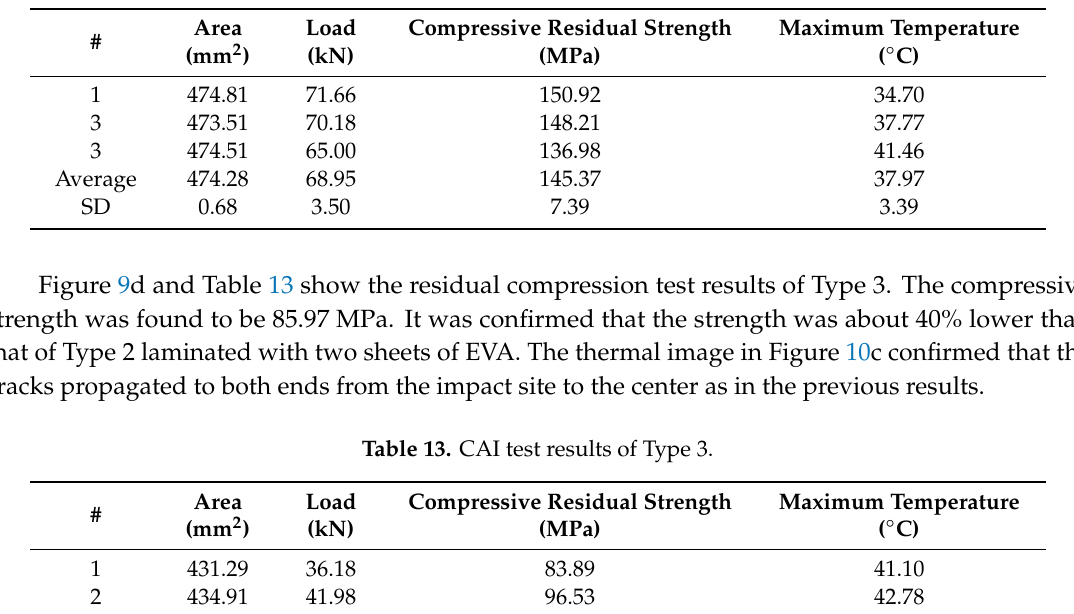
Table 12. CAI test results of Type 2.